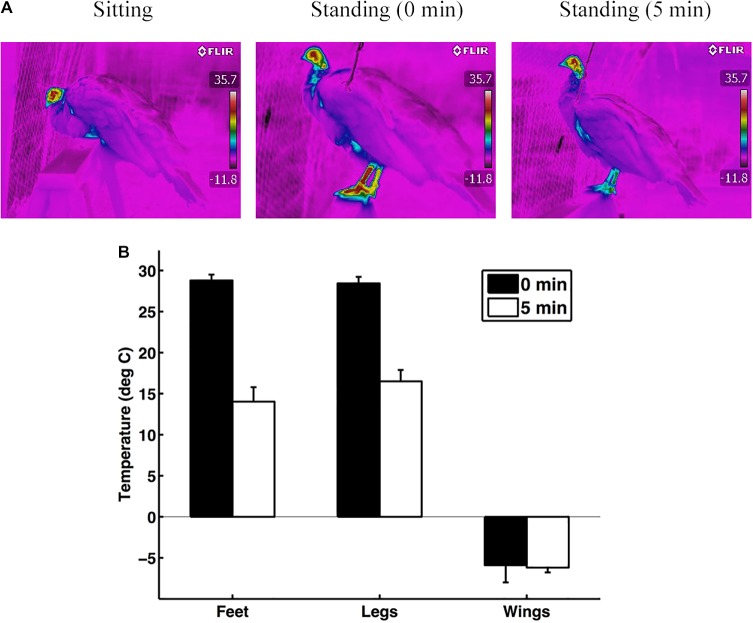
The effect of the leg-tuck posture on heat conservation. (A) Thermal images of a peahen sitting in the leg-tuck posture, immediately after she stands up from the leg-tuck posture (0 min), and 5 min after she stands up from the leg-tuck posture. (B) The temperature of the feet, legs, and wings immediately after birds stood up after being in the leg-tuck posture (0 min) and after the birds remained standing (5 min). Error bars represent mean±s.e.m.